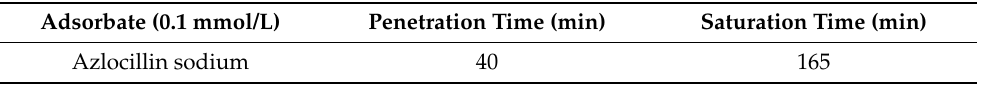
Table 1. Penetration time and saturation time of azlocillin